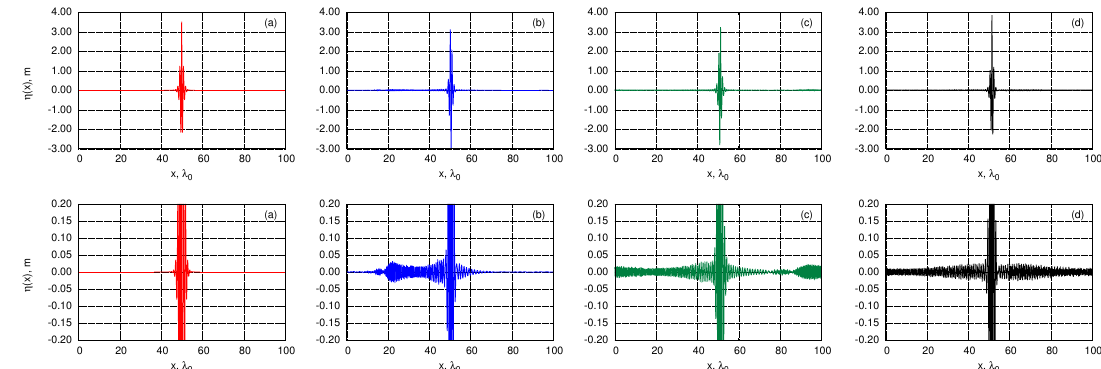
Figure 2. Propagation of single breather with the wave steepness µ ≈ 0.25 in the fully nonlinear model. The initial condition in physical variables was restored with the second order accuracy from variables of the Zakharov equation. ( Top ) row: the surface elevation η ( x ) at different subsequent moments of time. Panel ( a ) shows the initial surface profile (at t = 0); panel ( b ) corresponds to t = 1067 s ≈ 133.3 T 0 ; panel ( c ) corresponds to t = 2134 s ≈ 266.6 T 0 ; and panel ( d ) corresponds to t = 3201 s ≈ 400 T 0 ( Bottom ) row: zoom of the top row pictures.